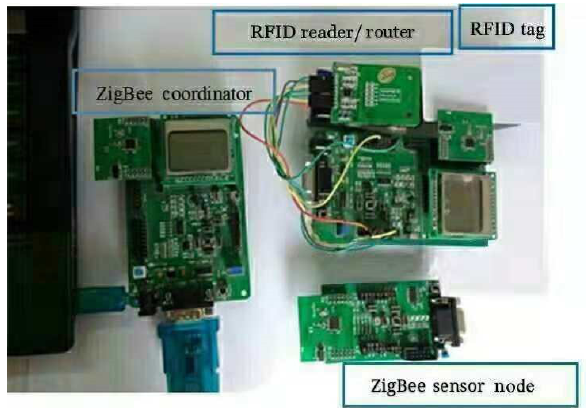
Figure 11. Hardware for integrated RFID and wireless sensor networks.